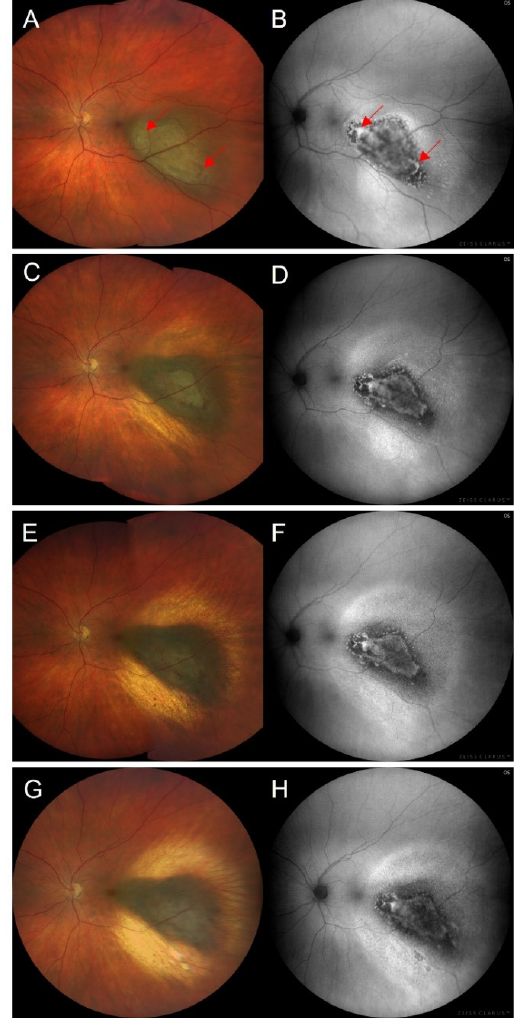
Figure 4. ( A , C , E , G ) Fundus photographs and ( B , D , F , H ) fundus autofluorescence images (illumination with 500–585 nm, FAF-Green) of a posterior choroidal melanoma ( A , B ) before and ( C – H ) after ruthenium-106 brachytherapy (CCA plaque, Eckert & Ziegler BEBIG, Berlin, Germany; scleral dosis 1600 Gy). ( C , D ) 3 months; ( E , F ) 9 months; ( G , H ) 18 months after brachytherapy. ( A ) The fundus photograph of the treatment-naive melanoma shows a pigmented lesion with overlying orange pigment (exemplified red arrows). ( C , E , G ) After brachytherapy, regression of the melanoma and surrounding chorioretinal scarring occurs. ( D , F , H ) Fundus autofluorescence imaging after therapy shows gradual fading of the increased autofluorescence signal of orange pigment and areas of progressive atrophy of the retinal pigment epithelium overlying the irradiated tumour. The surrounding irradiation field is characterised by increased fundus autofluorescence with a granular appearance. Fundus photographs and autofluorescence images were taken using the ZEISS CLARUS 700 (Carl Zeiss Meditec AG, Jena,